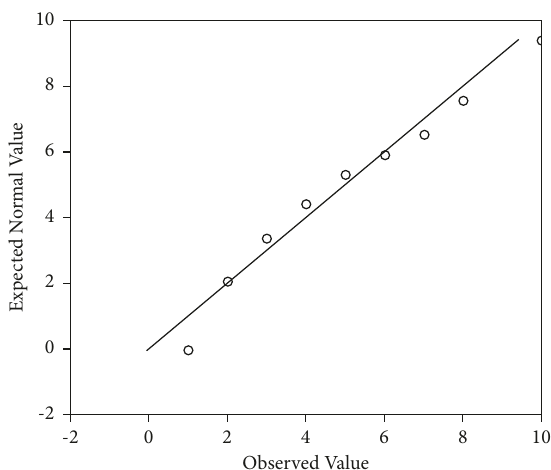
Figure 2: Graphic indicator of bar-on scores’ normality.